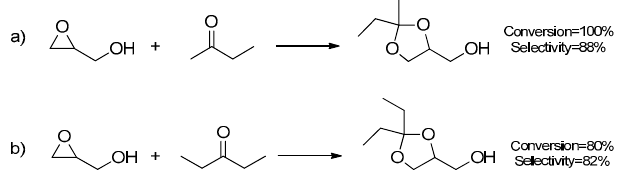
Figure 1. Glycidol conversion to solketal using Nafion NR50 (reaction conditions: glycidol/acetone moles ratio 1:43, catalyst loading 20 wt %, reflux).